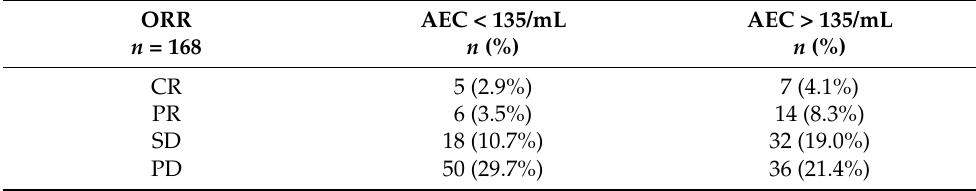
Table 4. ORR according to RECIST criteria 1.177 and basal AEC.